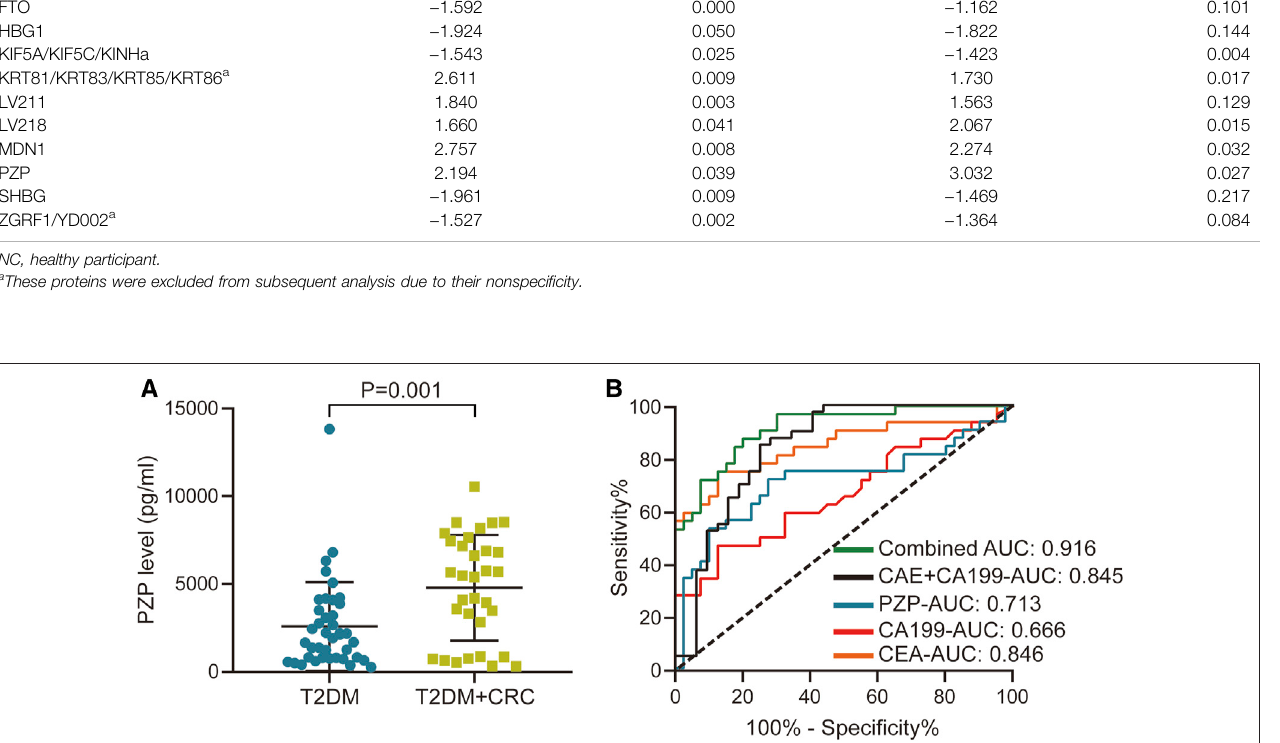
Frontiers in Molecular Biosciences |